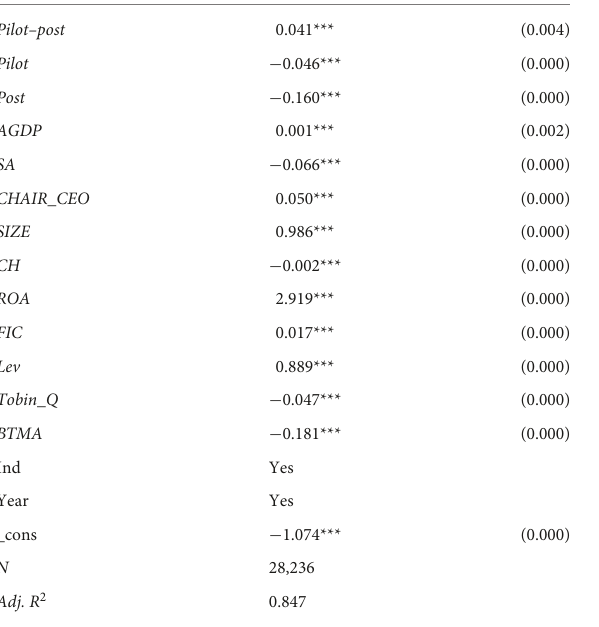
TABLE 6 Impact of low-carbon city pilot policy on enterprises’ sales revenue.